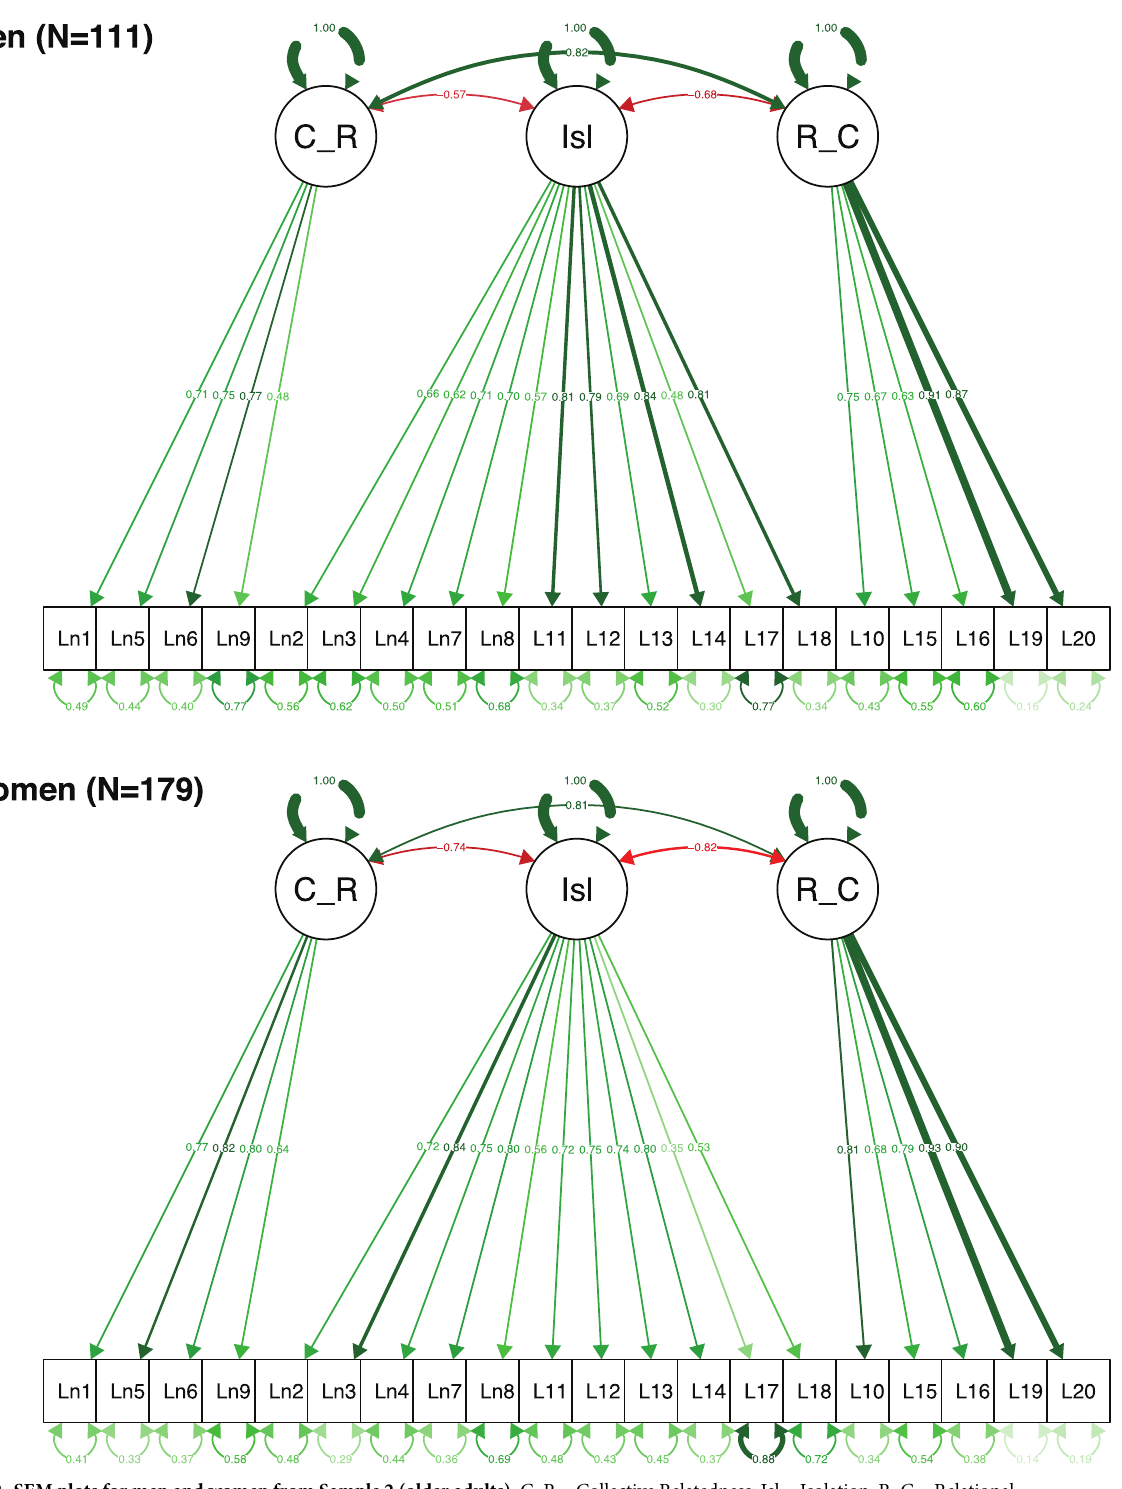
Fig 2. SEM plots for men and women from Sample 2 (older adults). C_R = Collective Relatedness; Isl = Isolation, R_C = Relational Connectedness. Note: Single headed arrows: factor loadings, double-headed arrows: covariances or error variances associated with items.